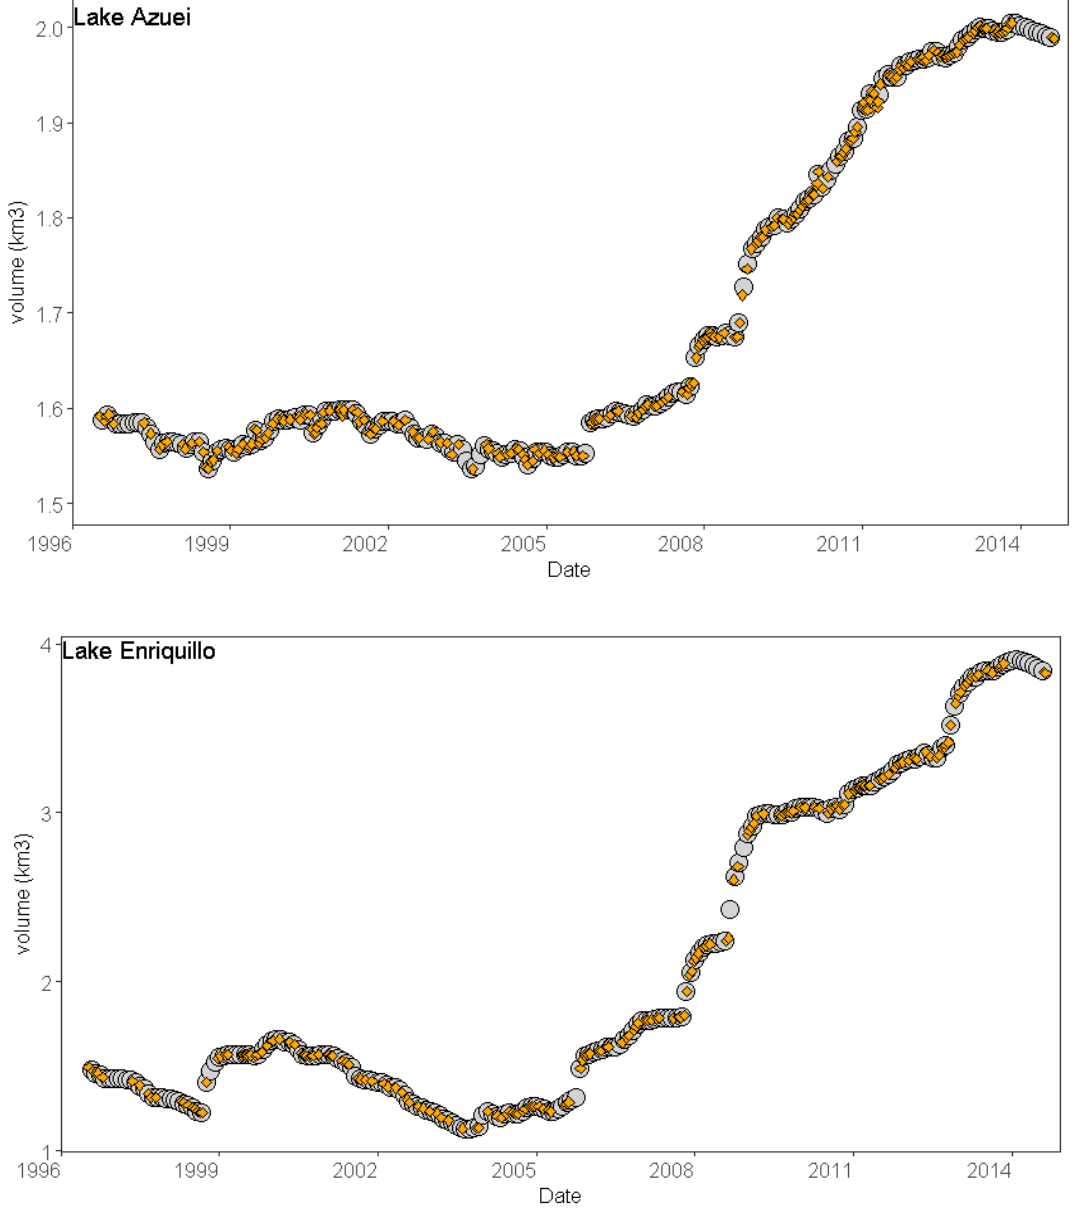
Figure5. LakeAzuei’sandLakeEnriquillo’smonthlyvolumetimeseries(greypoints)andobservational Figure 5. Lake Azuei’s and Lake Enriquillo’s monthly volume time series (grey points) and time series (orange observational time series (orange diamonds).